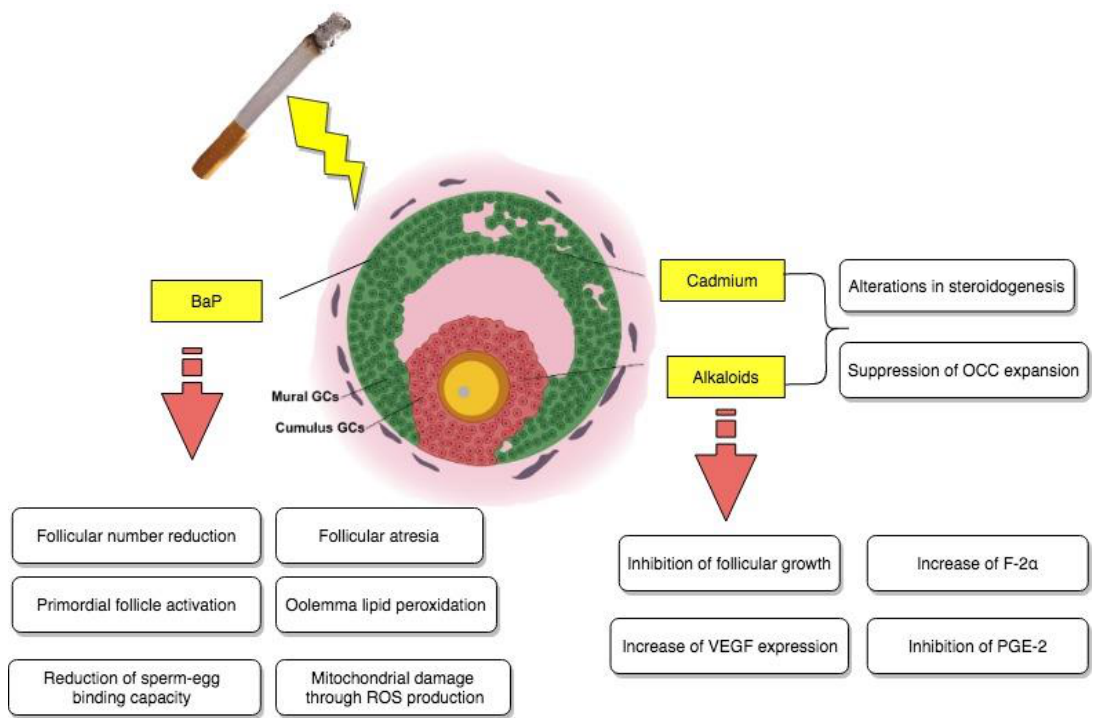
Figure 2. Direct impact of tobacco smoke-contained chemical substances, cadmium, BaP, and alkaloids on granulosa cells.